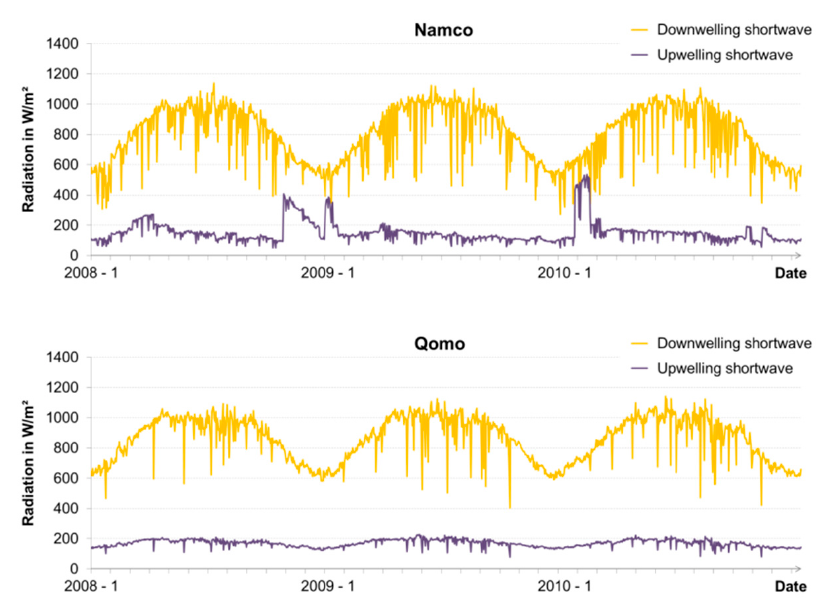
Figure 5. Time series of instantaneous solar incident (yellow) and reflected (purple) radiations for the pixels in which the ground stations used for the validation are located: BJ, Linzhi, NamCo, and Qomolangma (Qomo).